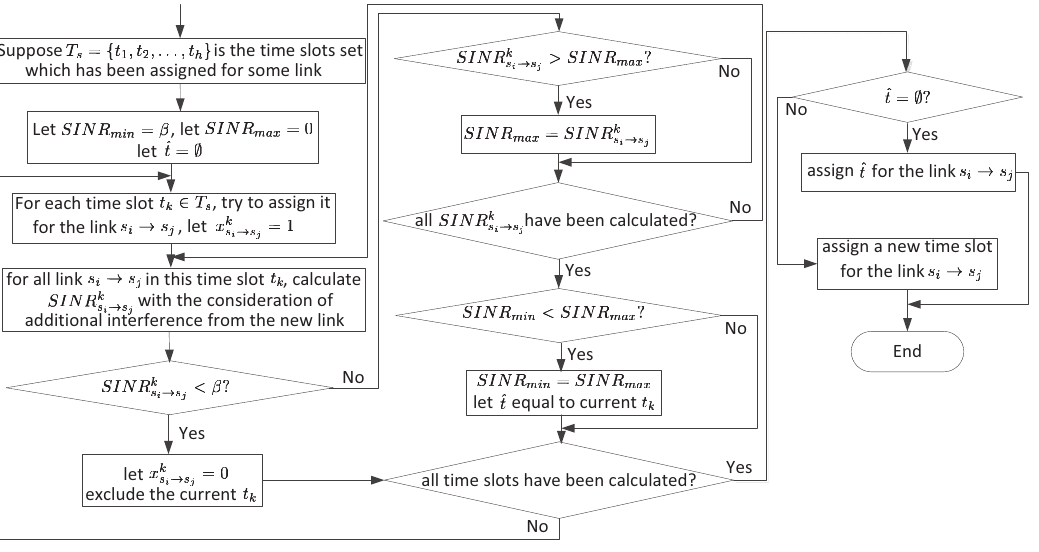
Figure 5. Time slot assignment for a new link s i → s j